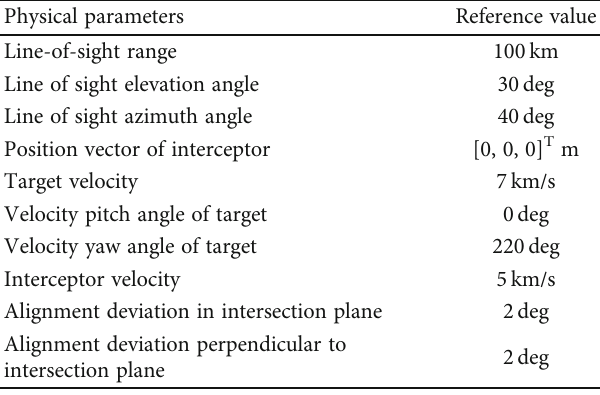
Table 1: Initial conditions of interceptor and target in the training